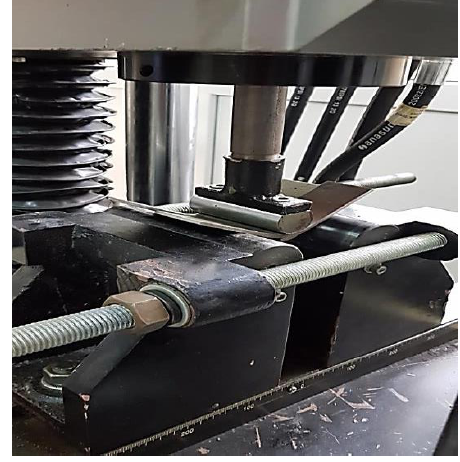
Figure10: Bending test